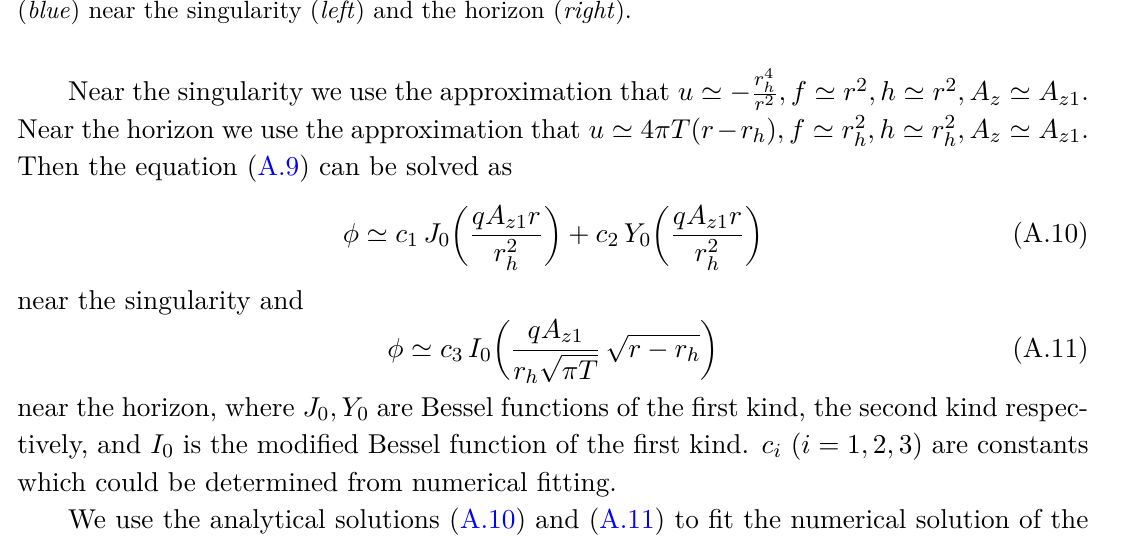
figure 8. We find that (A.10) fits the numerical solution well in the near singularity regime, while (A.11) fits the numerical solution well in the near horizon